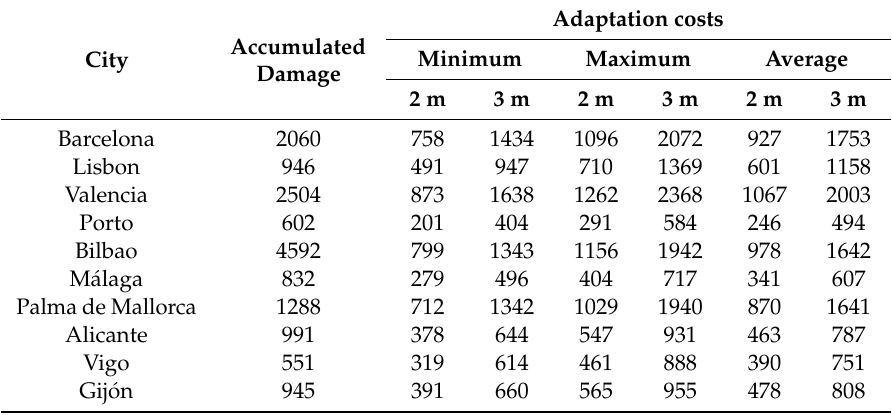
Table 5. Expected accumulated damage and adaptation strategies with standard height defences in 2100 (costs shown in million euros) for the 10 largest Iberian coastal cities, under RCP